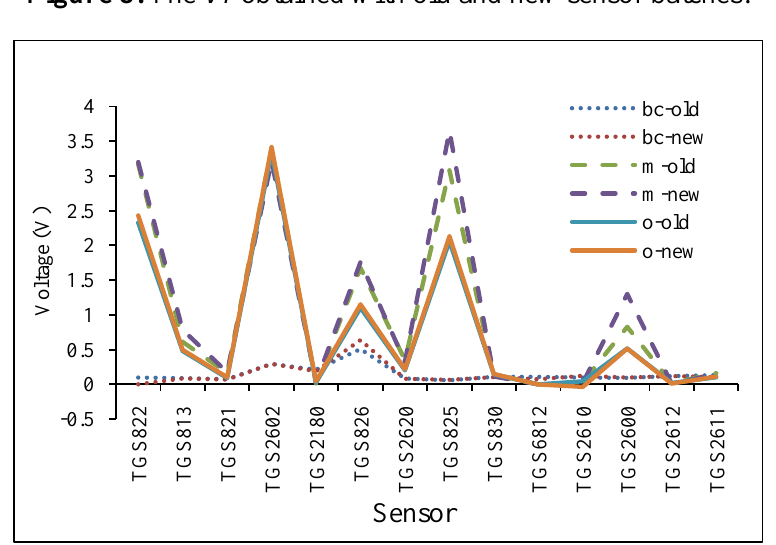
Table 4. The RSD obtained for 10 measurements of blackcurrant, mango and orange juices. Beverages